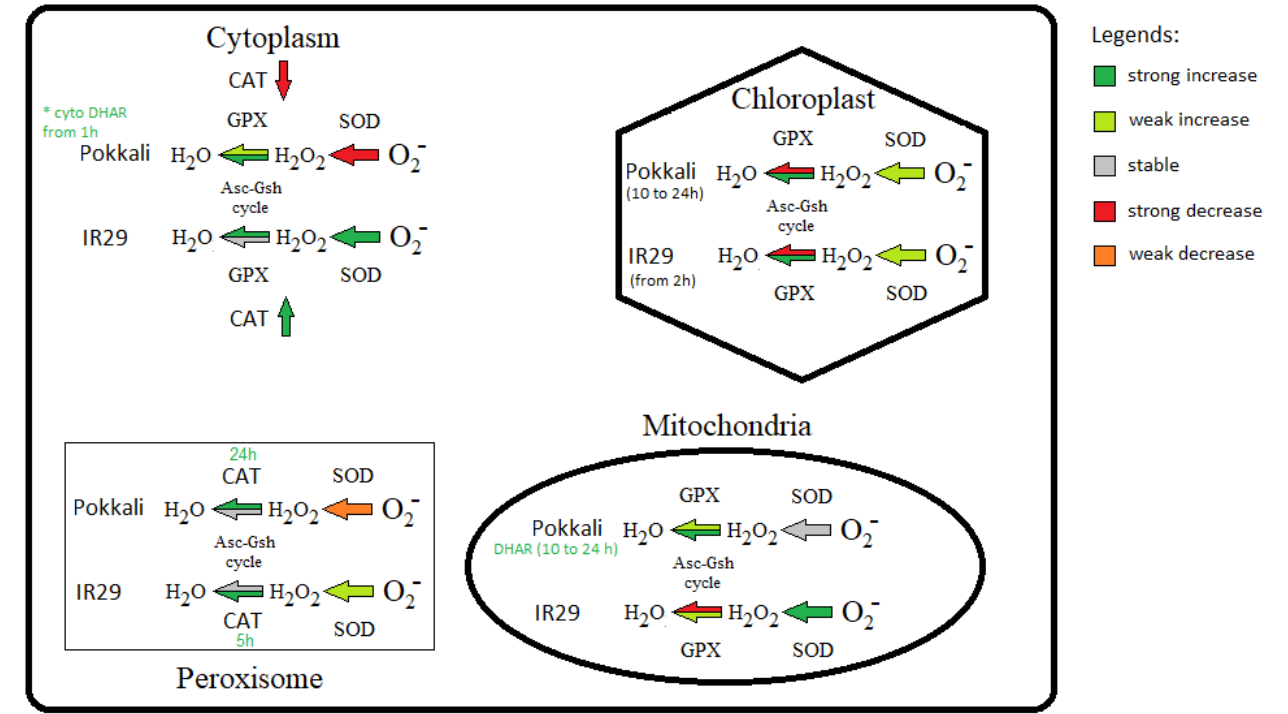
Figure 4. Schematic representation of antioxidant enzymes in different cellular compartments of Oryza sativa genotypes under salt stress. Significant values denoted substantial transcript increases or decreases, while non-significant values indicated weak increases or decreases according to Supplementary Tables S3 and S4.